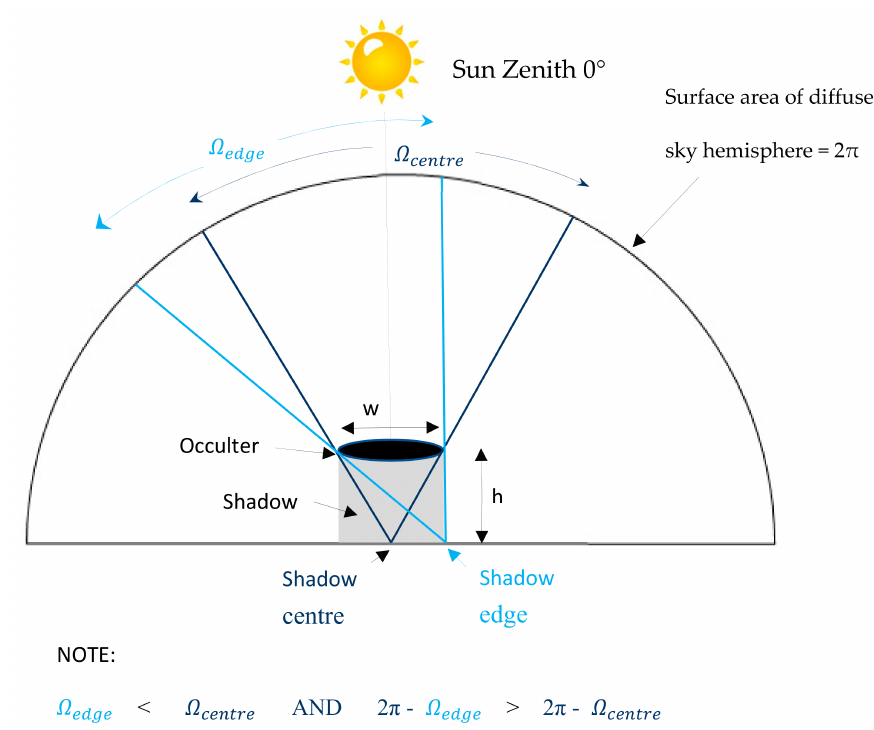
Figure 2. Two solid angles, Ω centre and Ω edge subtended onto sky hemisphere surface from within a shadow cast by an occulter at height h, width w at a sun zenith of 0 ◦ . The shadow edge has less of sky hemisphere obstructed than the shadow centre. Adapted from Lynch